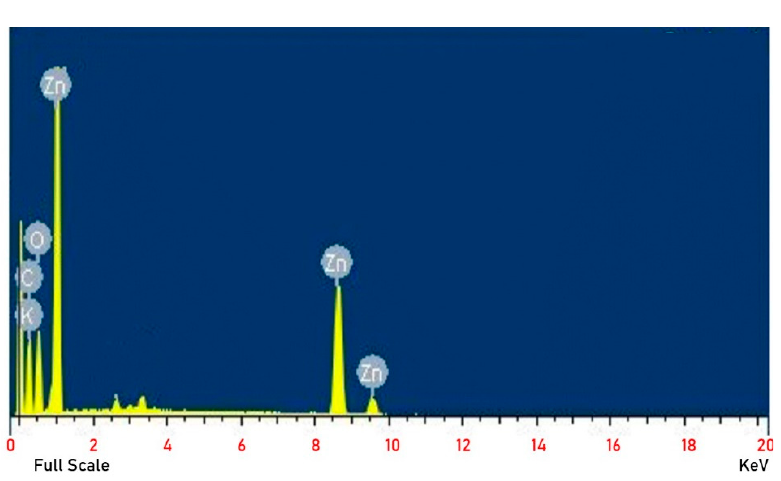
Figure 7. EDAX profile of ZnO nanoparticles.